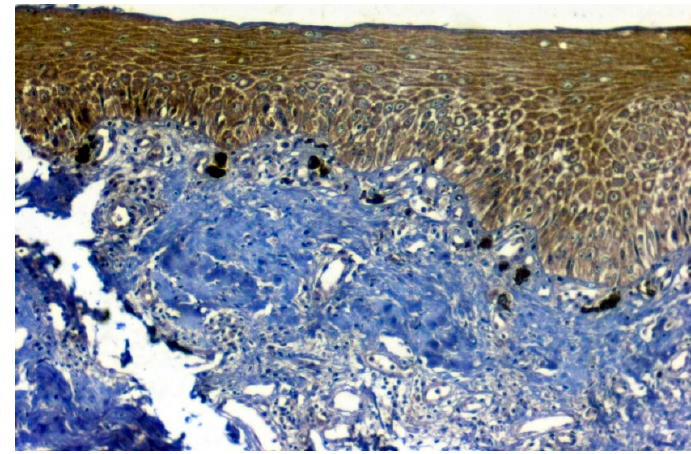
Figure 7. IHC for 14 ‐ 3 ‐ 3 ε in normal samples (under 20× magnification). 274